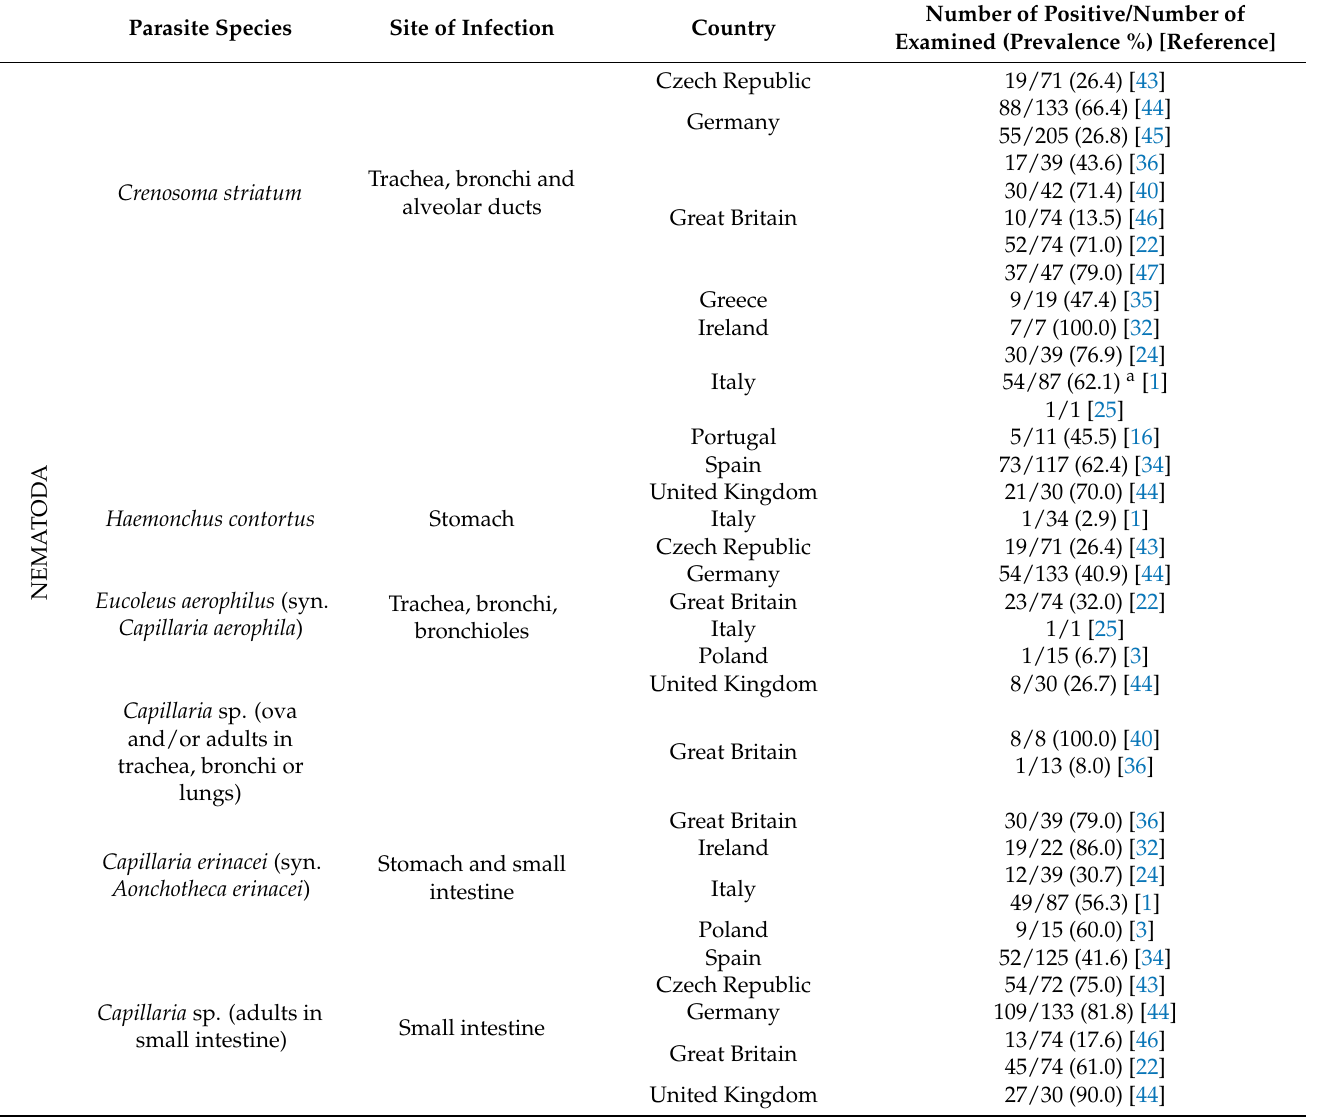
Table 3. Presence and prevalence data from the literature on parasites of the European hedgehog ( Erinaceus europaeus ) in different European countries. Number of positive animals or prevalence were calculated if not directly reported in the original studies. Reports describing Capillaria sp. eggs in feces, with no distinction made between Eucoleus aerophilus or gastrointestinal capillariid eggs, were